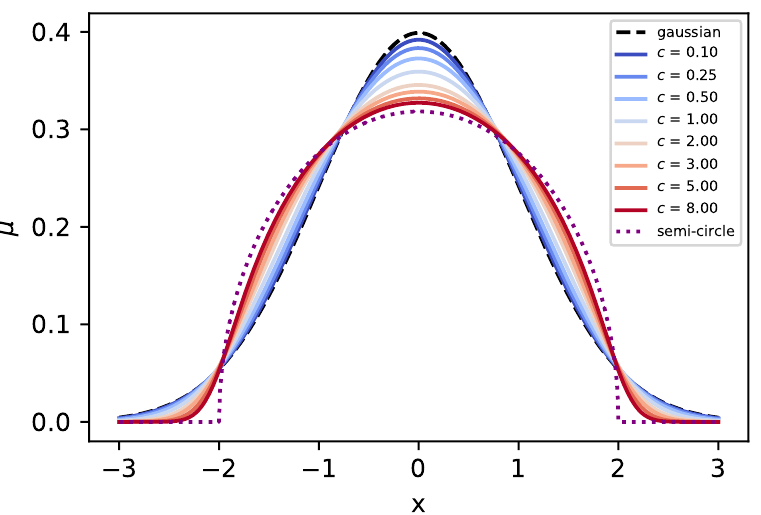
Figure 2: Plots of the c -Gaussian distribution defined in (161) for different values of c , the dashed lined corresponds to the classical limiting case and the doted line the free limiting